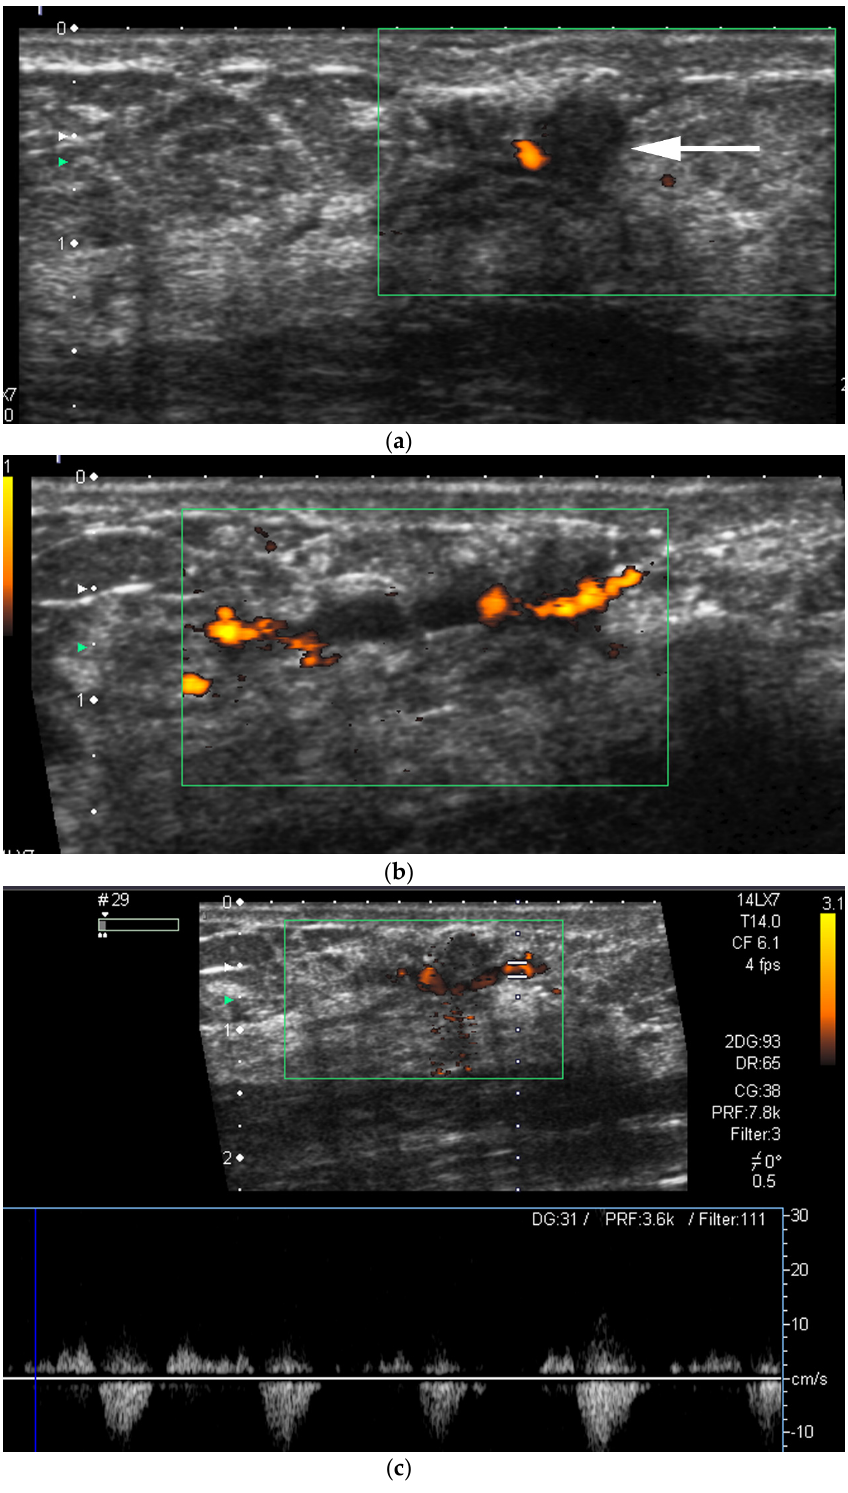
Figure 4. US-guided procedures images of a clinically palpable retroareolar mass in a 81 year-old patient on aspirin. Transverse US images show a hypoechoic mass with angular margins measuring 6 mm associated with a rim vascularity at color Doppler interrogation ( a ) (arrow). Sonographically guided 14-gauge core biopsy. Post biopsy US image shows an active bleeding at the biopsy site ( b , c ). Pathology yielded intermediate-grade invasive ductal carcinoma.